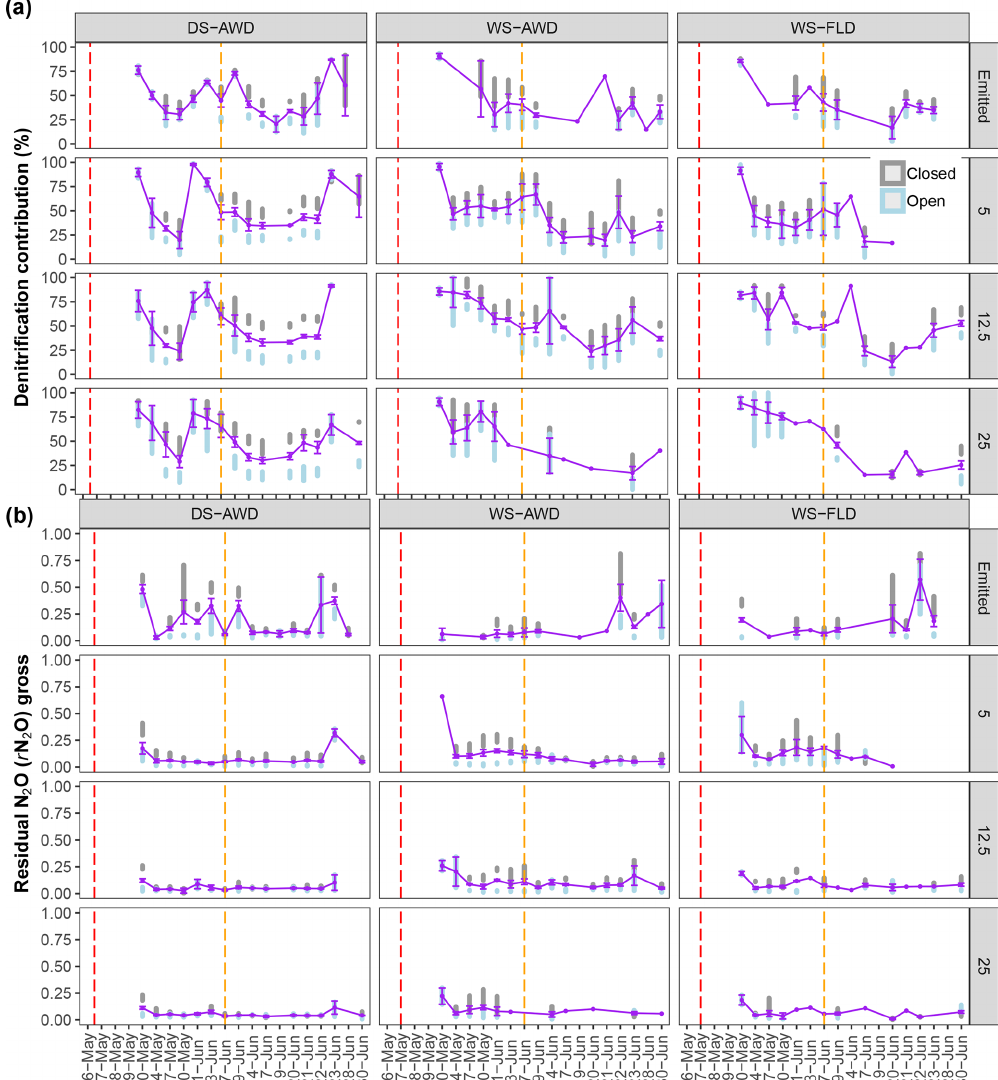
Figure 5. Modeled denitrification/nitrifier-denitrification contribution and gross r N 2 O of open (grey bars), closed (blue bars) and mean (purple points and line) systems predicted by a two end-member mixing model using δ 18 O-N 2 O and SP values. For open- and closed-system dynamics, the shaded bars represent the standard deviation range for each treatment × depth combination. The purple error bars represent the standard deviation around the mean. Red and orange dashed vertical lines represent the date of seeding and fertilization in each treatment,